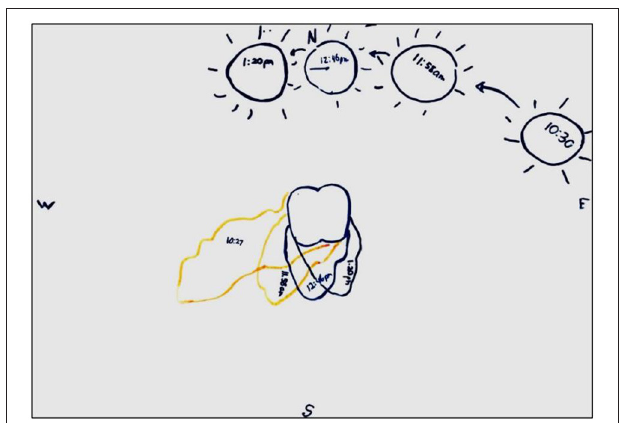
FIGURE 4 | Class diagram that Colin constructed using the gnome, over four episodes.